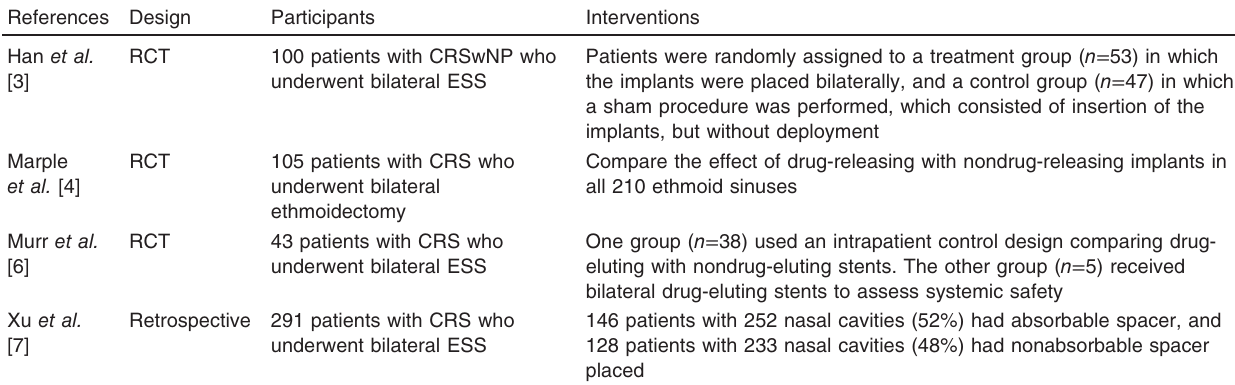
Table 2 Summary of included studies